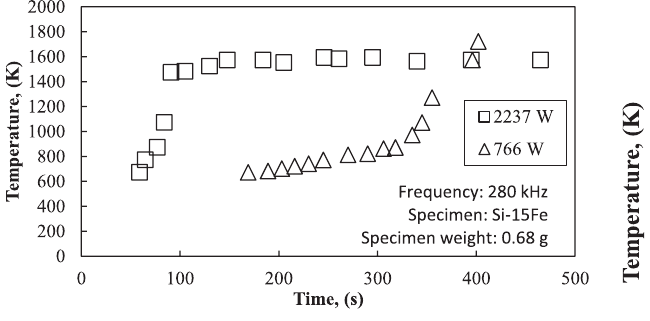
Fig. 9: Heating behavior of silicon-iron alloy droplets at two levels of applied power